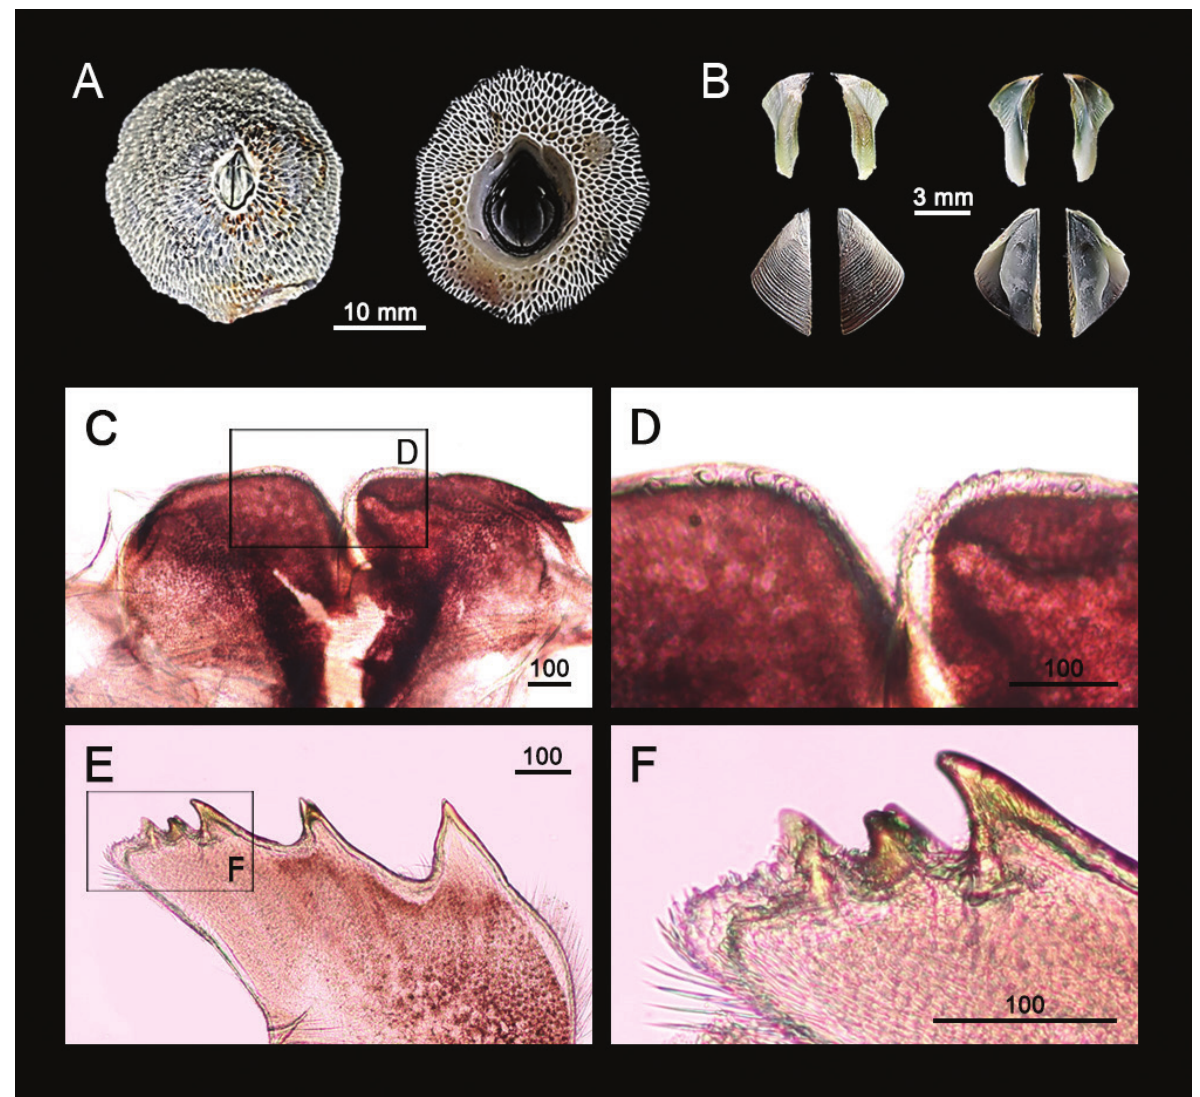
Figure 6. Tetraclita kuroshioensis collected from (BUU16.TC.TK01) from Na Tai beach, Phang-nga. A. Dorsal and ventral view of external shell, B. External (left panel) and internal (right panel) view of tergum (upper panel) and scutum (lower panel), C–F. Light microscopy on mouthparts, C. Labrum, D. Close up on the teeth of the labrum, E. Mandible, F. Close up on the lower margin of mandible. C–F. Scale bars in